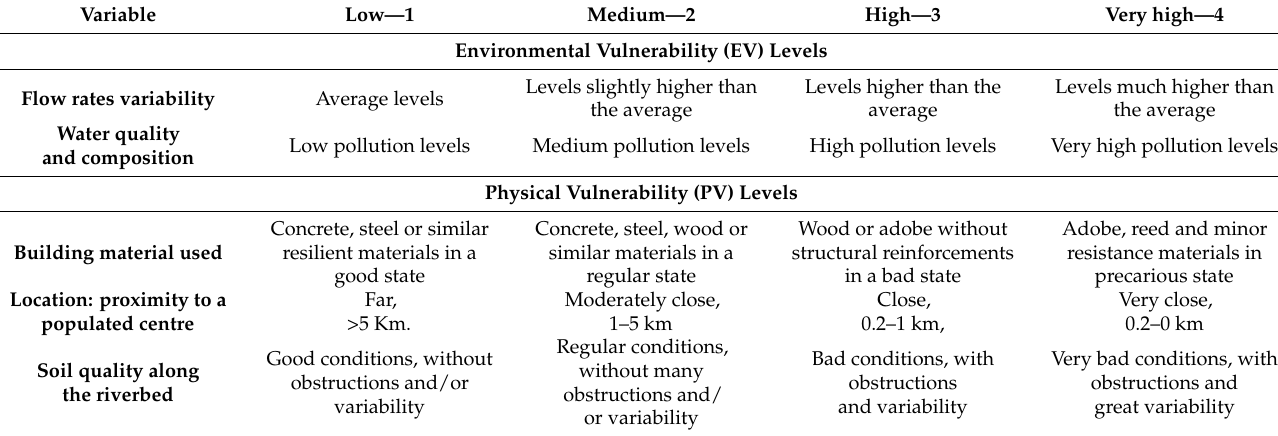
Table 5. Hydrological vulnerability assessment